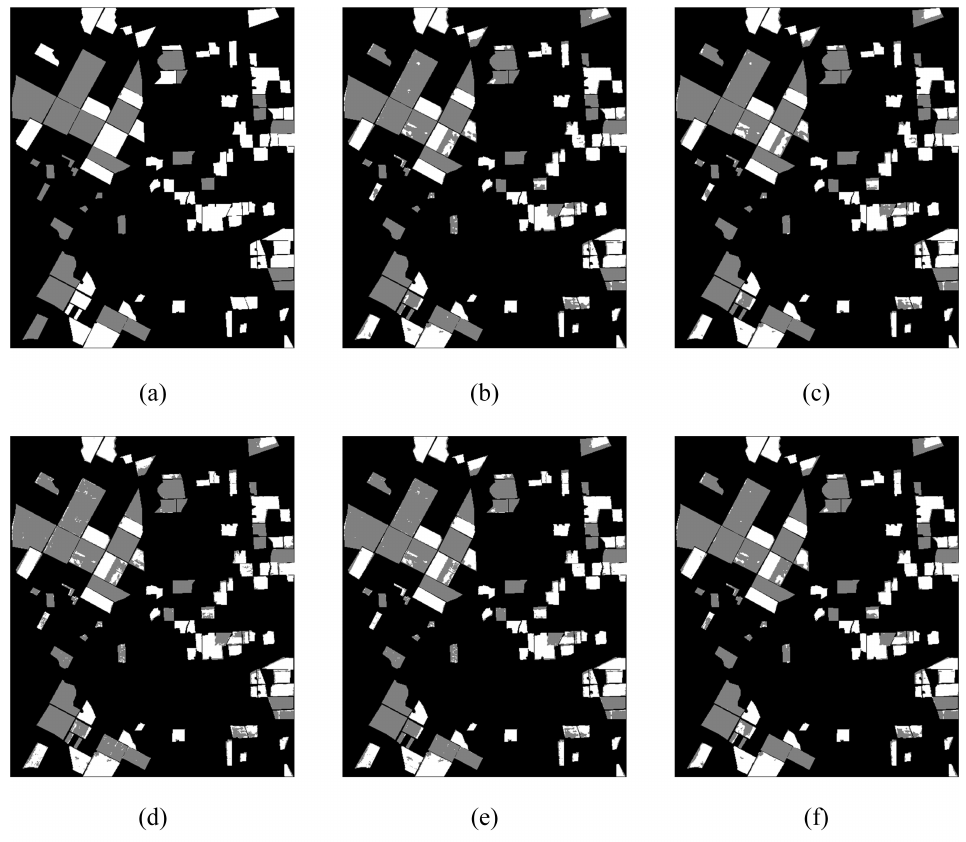
Figure 6. Comparison results of different algorithms on the Bay Area dataset. ( a ) Reference map.